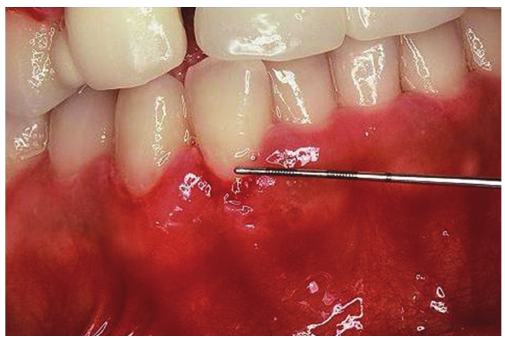
Figure 2: Gentle palpation with a periodontal probe elicited some desquamation of the gingiva around tooth no. 27.